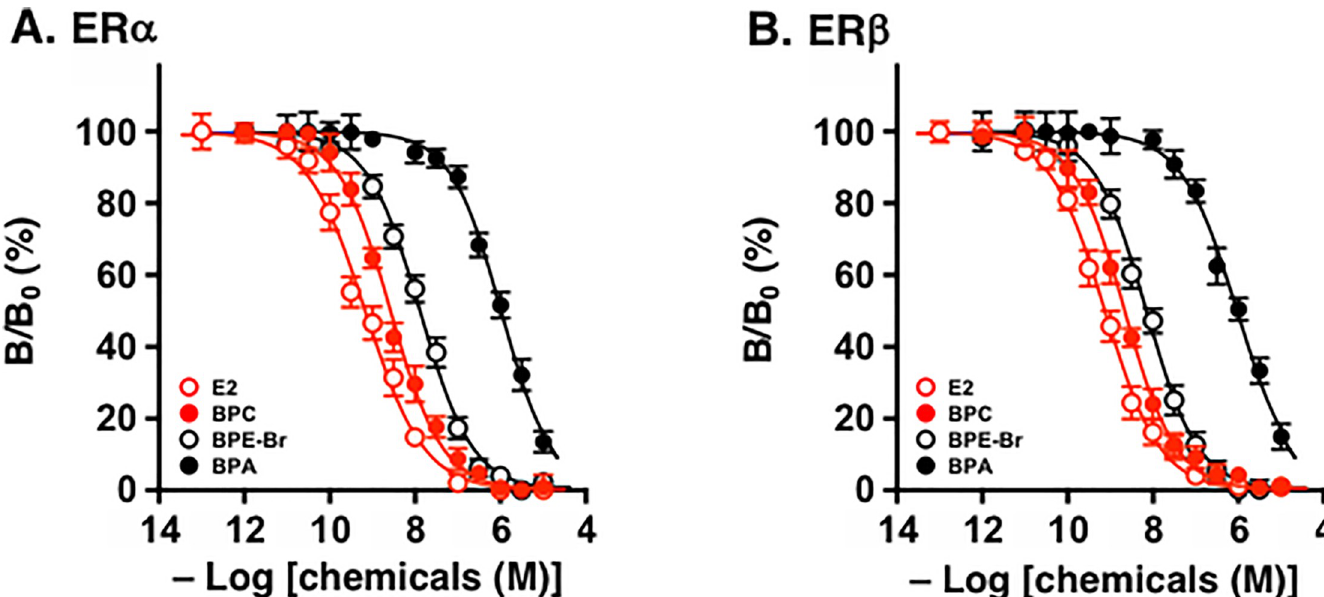
Fig 2. Competitive radio-ligand receptor-binding assays. Dose-response receptor binding curves are shown for the assays for ( A ) ER α and ( B ) ER β . 17 β -estradiol (E2) was used as an internal standard compound in the assays for both ER α and ER β , in which tritiated [ 3 H]E2 was used as a radiolabeled receptor tracer. The Y axis is expressed by the normalized binding data from 100% (no competitor chemical) to 0% (nonspecific binding at maximal concentrations of competitor). Log[chemicals (M)] is the logarithm of the concentration of competitor chemicals plotted on the X-axis.